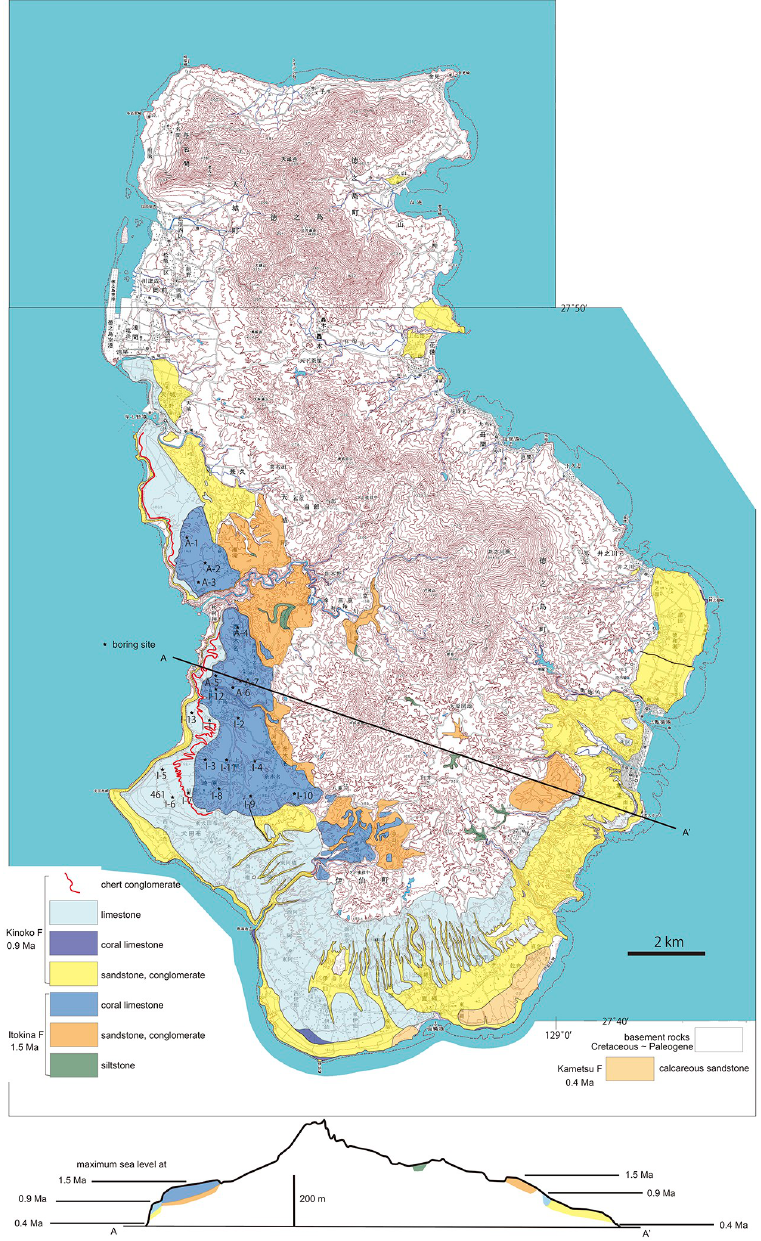
Fig 15. Geological map and cross section (below) of Tokuno-shima island. Three terraces consisting of the 1.5, 0.9 and 0.4 Ma limestone show three episodes of uplift or progressive uplift with erosion of wavecut benches during high sea level stands. Note the lack of coastal plains at 0.9 and 0.4 Ma, with development of 100-m-high sea cliffs instead. Background: Digital topographic maps of 1: 25,000 scale, the Geospatial Information Authority of Japan.